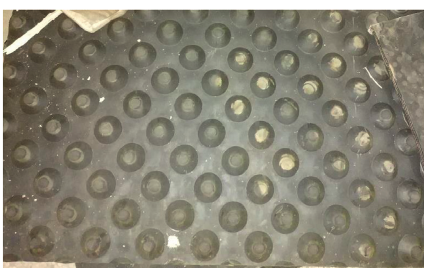
Figure 6: The structure of rubber mat used in this work.